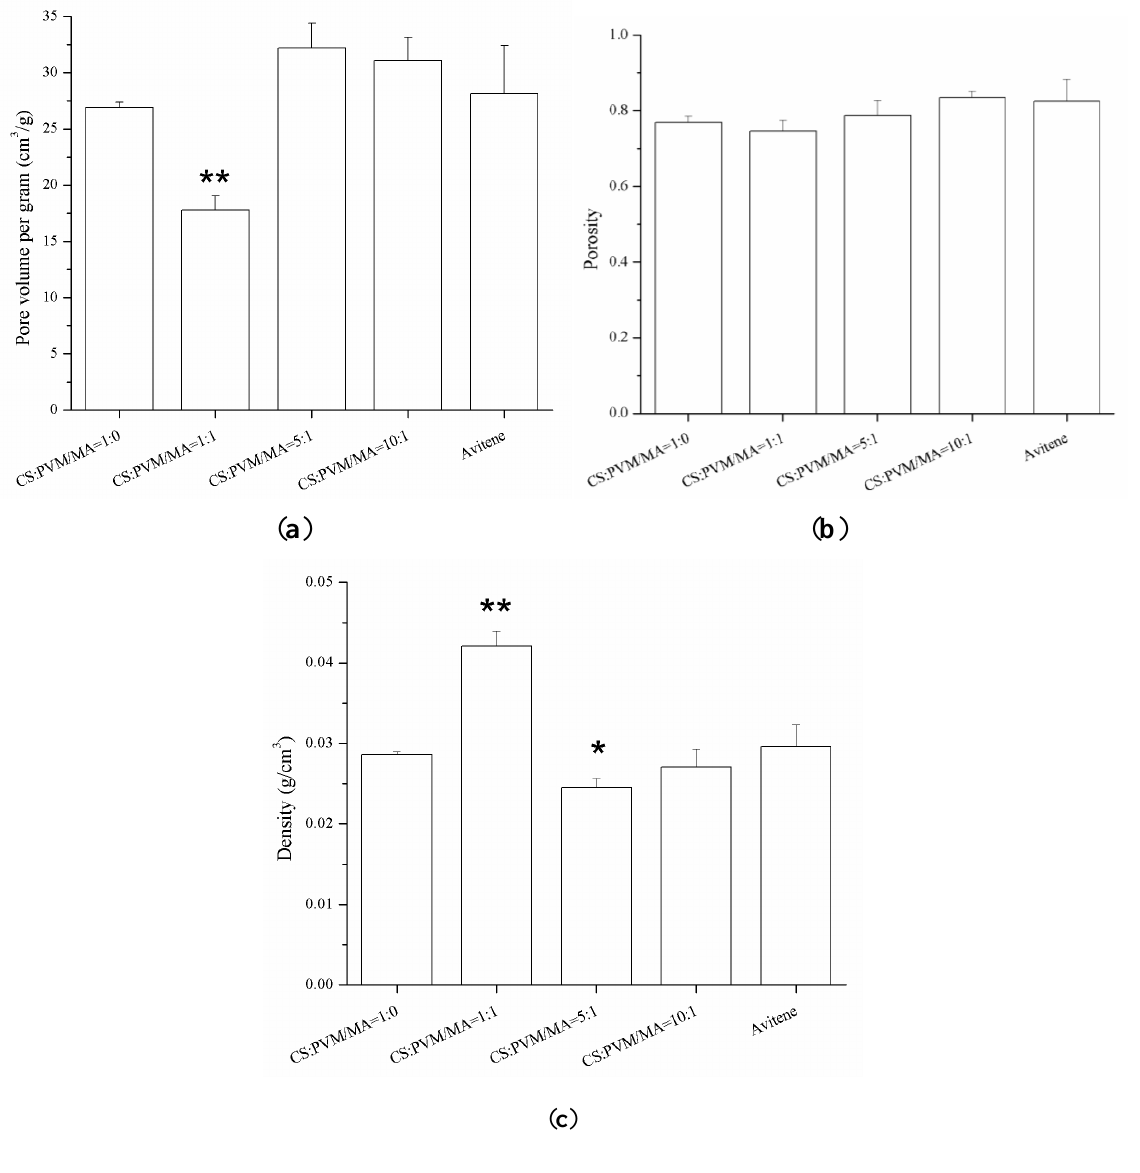
Figure 5. ( a ) Pore volume per gram of plain CS, Avitene ® , and CS-PVM/MA sponges; ( b ) porosity of plain CS, Avitene ® , and CS-PVM/MA sponges; and ( c ) density of plain CS, Avitene ® , and CS-PVM/MA sponges. The “*” indicates a significant difference between the prepared sponge and Avitene when p < 0.05, while the “**” indicates a significant difference between the prepared sponge and Avitene when p < 0.01 (Student’s t-test, n =